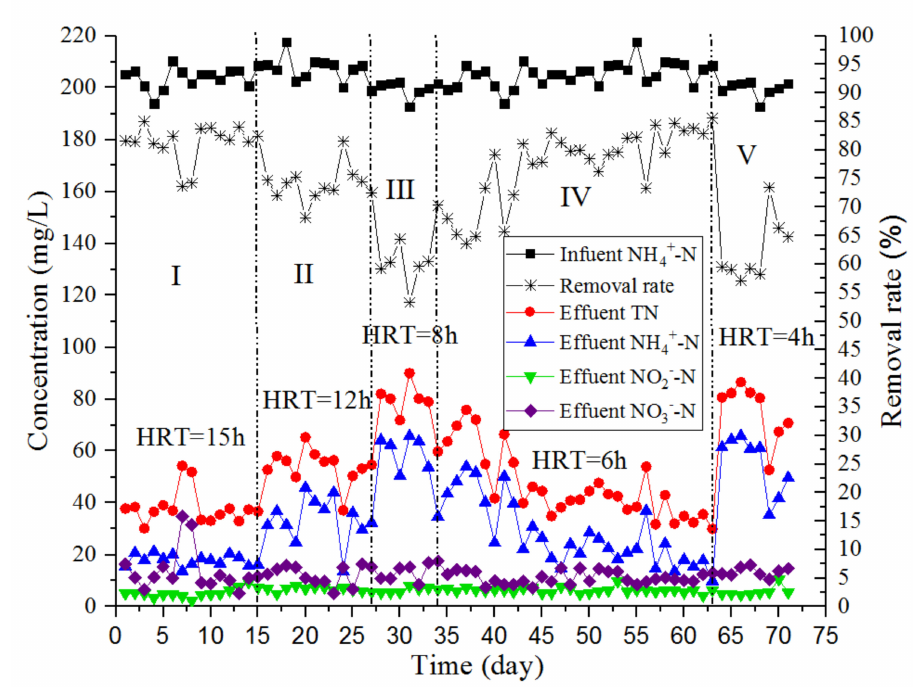
Figure4. ChangesinthecontentsofTN,NH 4 + -N,NO 2 − -N,andNO 3 −